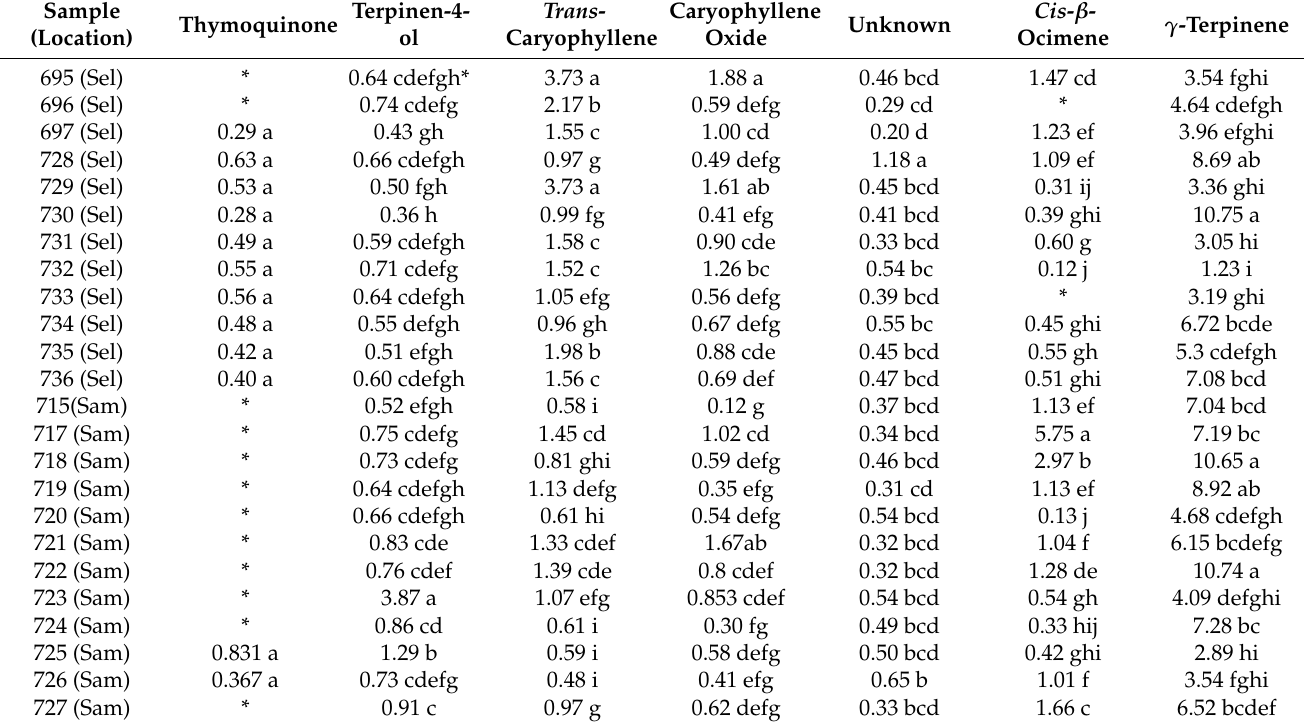
Table 6. Mean concentration (%) of thymoquinone, terpinen-4-ol, trans -caryophyllene, caryophyllene oxide, unknown, cis- β -ocimene, and γ -terpinene obtained from 24 samples of S. pilosa collected at the 2 locations (Sel = Selce, Sam =